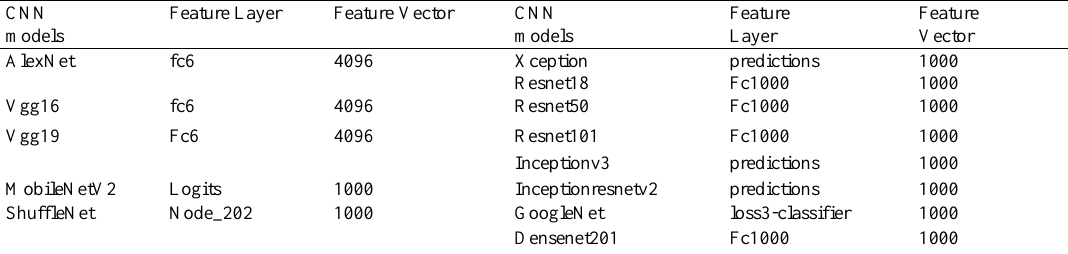
Table 3. Details of feature layer and feature vector of CNN